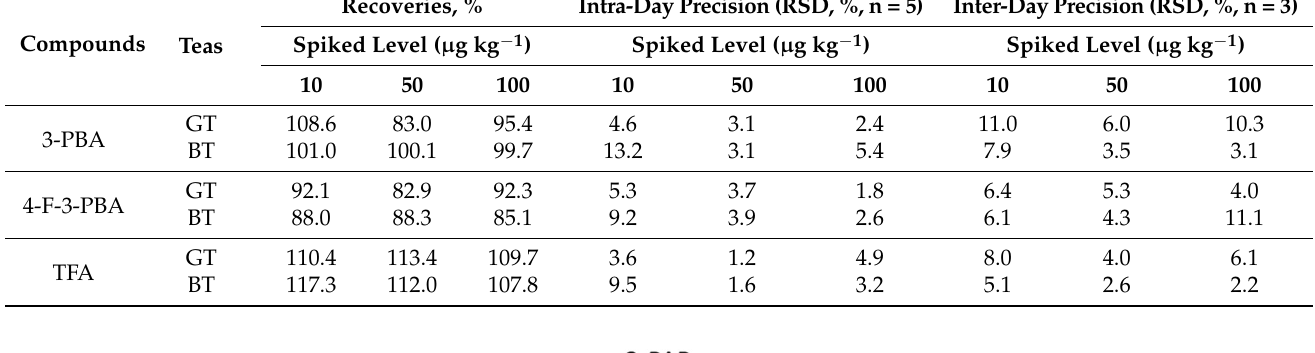
Table 5. Recovery, relative standard deviations (RSDs), LOD, and LOQ were obtained for the target compounds in green tea (GT) and black tea (BT).